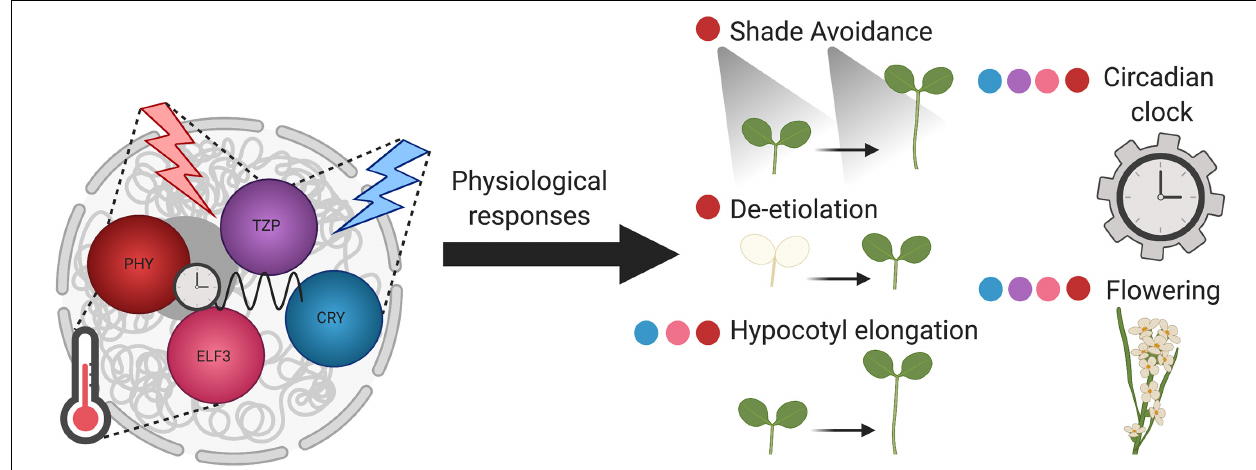
FIGURE 1 | Plant nuclear bodies coordinate environmental input with physiological responses. Phytochrome B photobodies (red), TZP (purple), CRY (blue), and ELF3 (pink) bodies, perceive different environmental stimuli. Phytochrome photobodies and TZP both respond to red light, whereas CRY bodies respond to blue light. TZP integrates red and blue light signaling. PhyB photobodies and ELF3 bodies are sensitive to temperature cues. Phy, TZP, CRY, and ELF3 bodies sense circadian clock input signals. The components of these nuclear bodies transduce environmental signals to diverse physiological outputs, represented by the colored dots adjacent to the developmental process. Overall, these plant nuclear bodies act as environmental sensors.